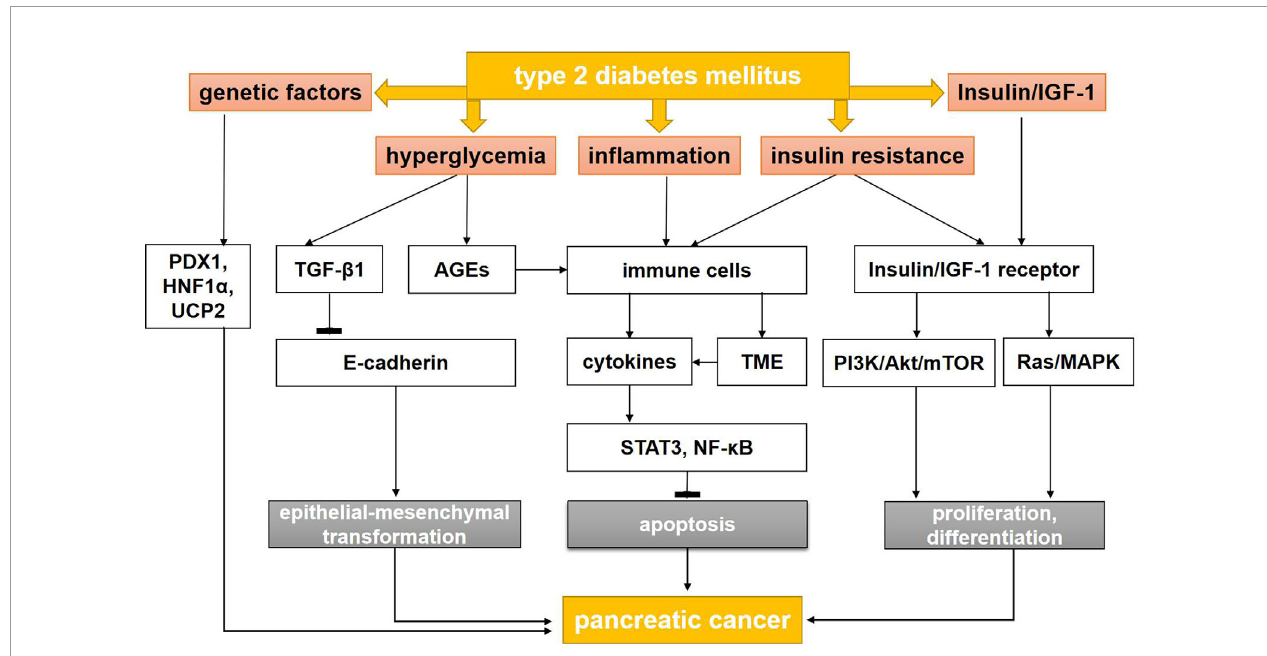
FIGURE 1 | The mechanisms between type 2 diabetes mellitus and pancreatic cancer. AGEs, advanced glycation end products; AMPK, adenosine monophosphate protein-activated kinase; IGF-1, insulin-like growth factor-1; LKB, liver kinase B; MAPK, mitogen-activated protein kinase; mTOR, mammalian target of rapamycin; NF- k B, nuclear factor kappa B; PI3K, phosphatidyl inositol-3 kinase; STAT3, signal transducer and activator of transcription 3; TGF- b 1, transforming growth factor- b 1; TME, tumor microenvironment; PDX1, pancreatic and duodenal homeobox-1; HNF1A, HNF1 Homeobox A; UCP2, uncoupling protein